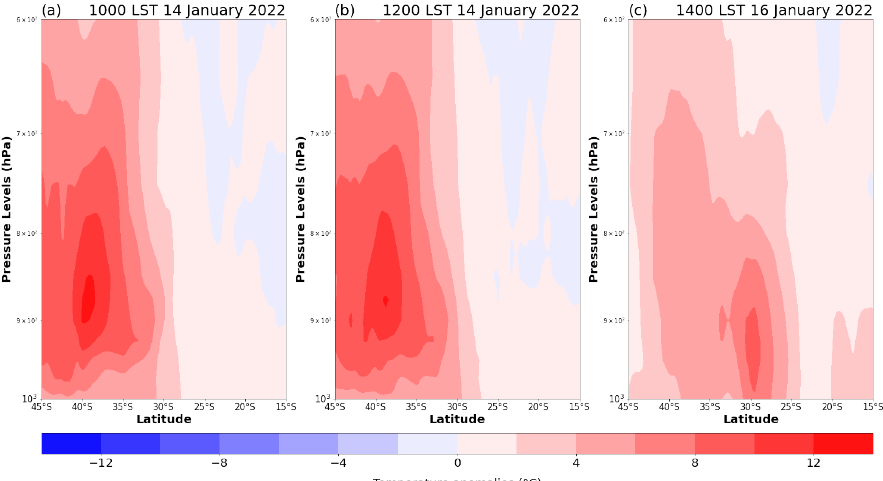
Figure 4. Latitude-height cross section in 46 ◦ W–60 ◦ W of air temperature anomalies at: ( a ) 14 1000 LST; ( b ) 14 1200 LST; ( c ) 16 1400